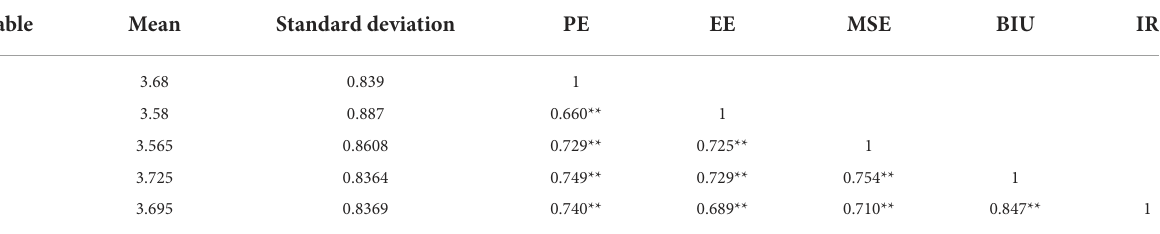
TABLE 3 Descriptive statistics.